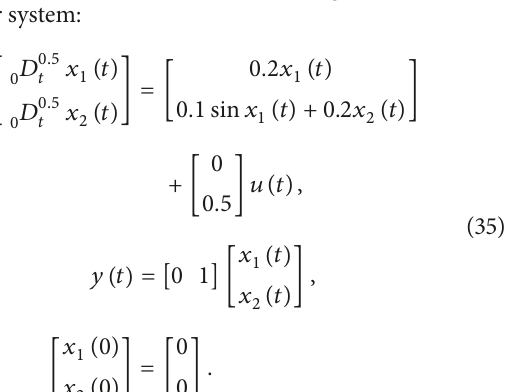
Figure 3: System outputs of (𝐼 2 )